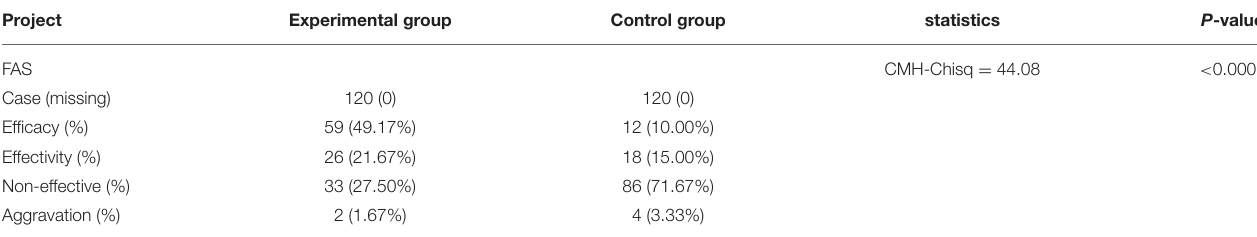
TABLE 6 | Comparison of curative effect of angina pectoris symptoms.